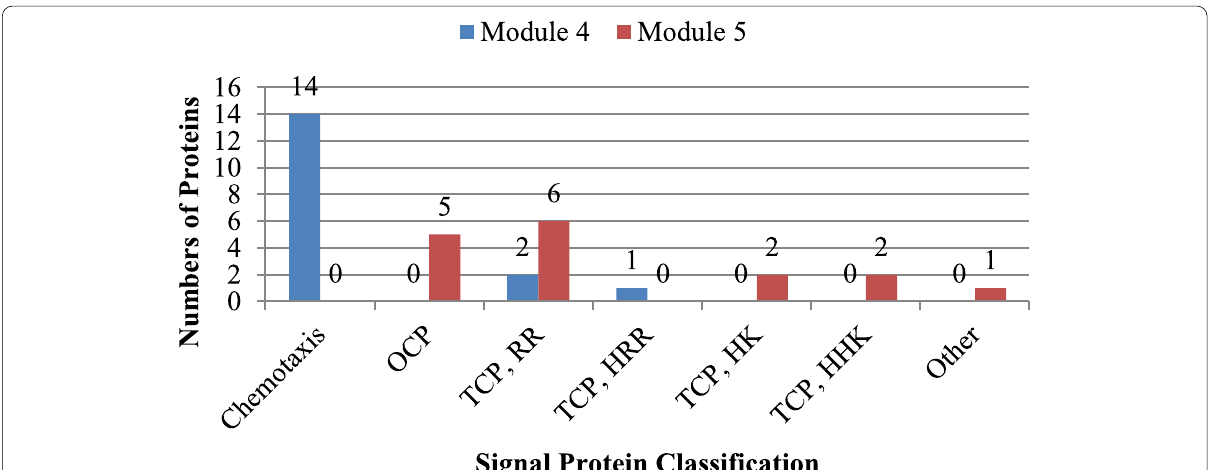
Fig. 4 Classification of signal transduction proteins in modules 4 and 5. OCP, one‑component proteins; TCP, two‑component proteins; RR, response regulator; HRR, hybrid response regulator; HK, histidine kinase; HHK, hybrid histidine